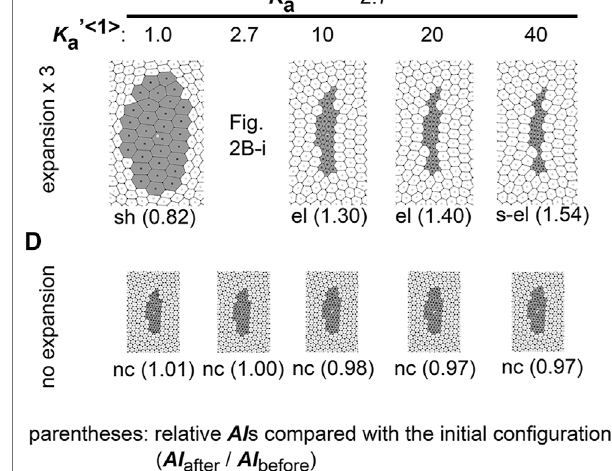
FIGURE 2 | Difference in area elasticity causes elongation of cell cluster onexpanding fi eld. (A) Theinitialcon fi gurationofsimulationisshown.Thegray and white cells are type 1 and type 0, respectively. The whole view of the con fi guration is provided in Supplementary Figure S1 . (B) Simulation outcomes under the same value between K ′ < 0 > a